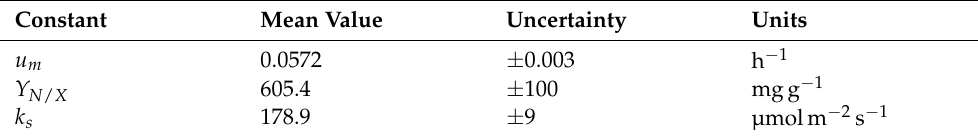
Table A5. Parameter uncertainty for model